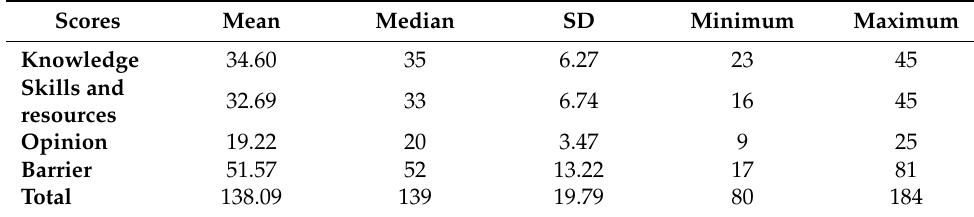
Table 6. Description of the generated scores.